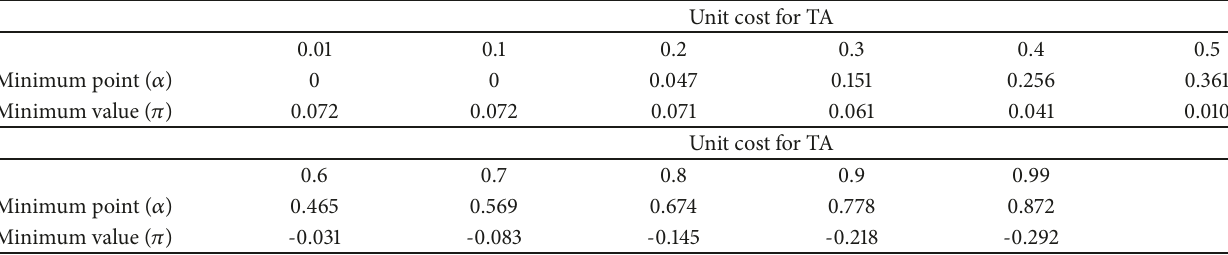
Table 3: Expected minimum profit under different unit cost of